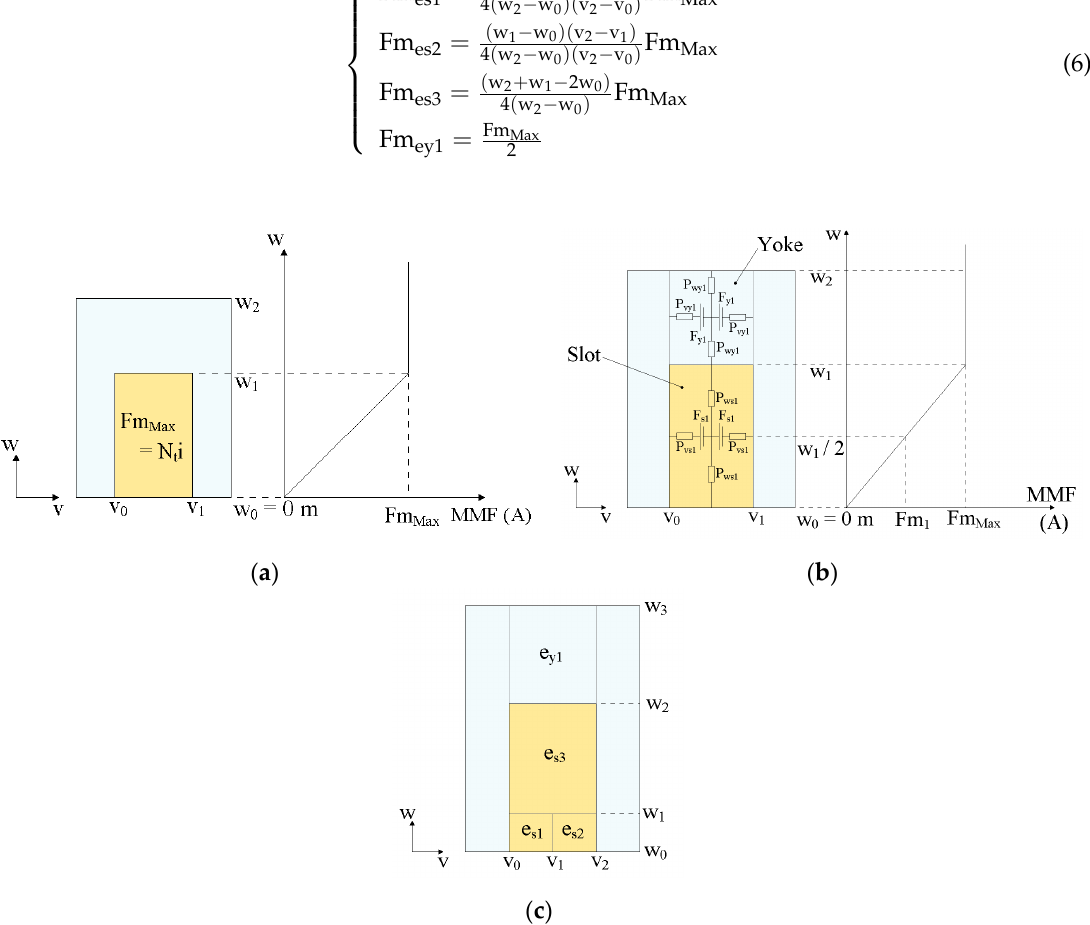
Figure 22. Magneto-motive force (MMF) coil variation.